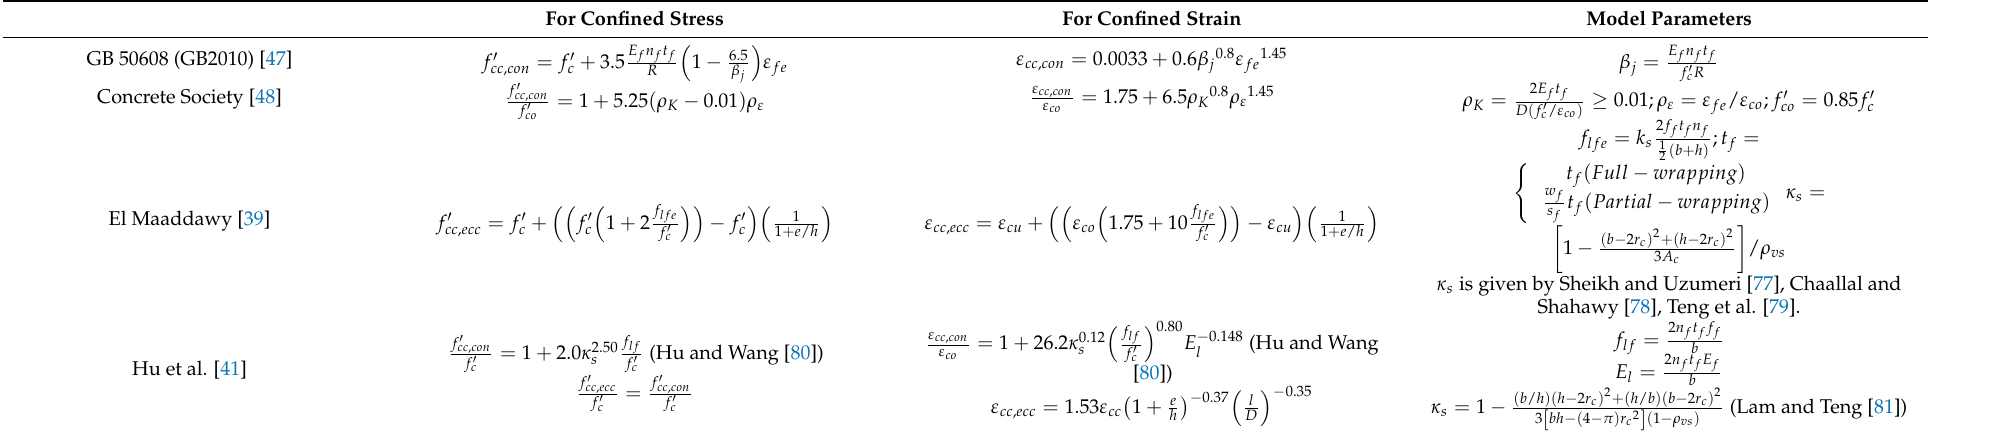
Table A2. Summary of existing confined stress and corresponding strain